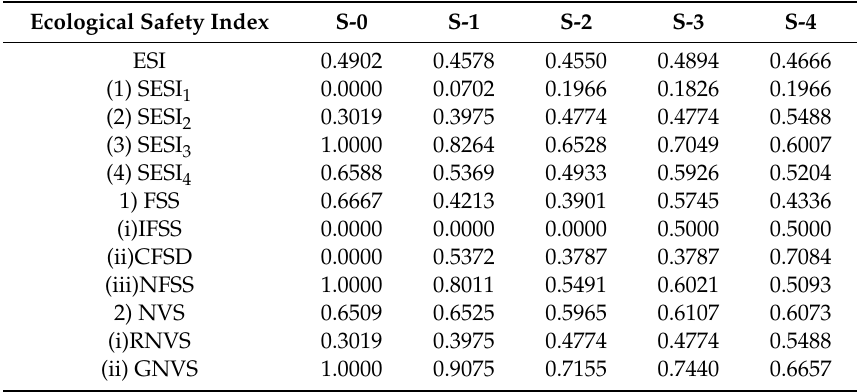
Table 8. Ecological safety index in di ff erent scaled water-saving irrigation